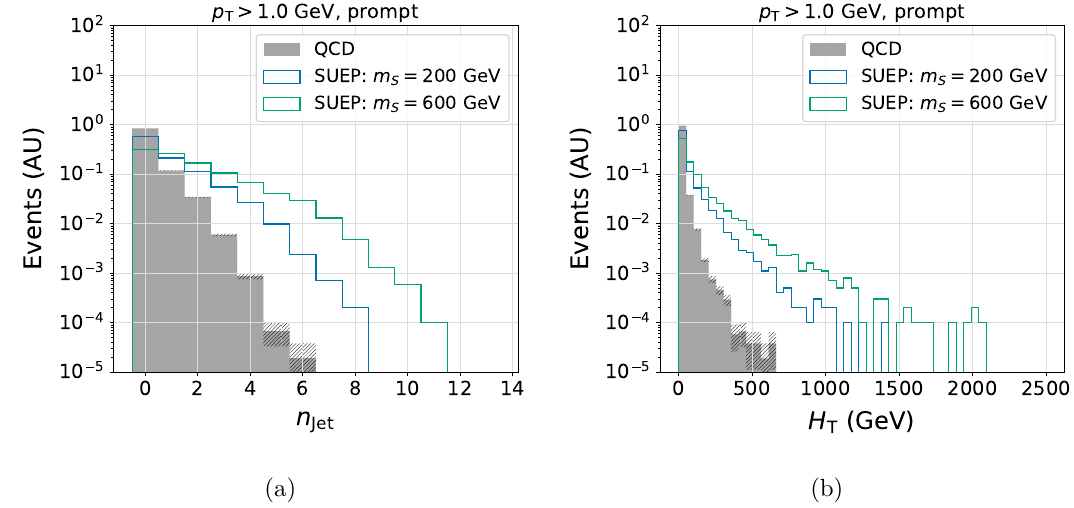
Figure 23. The number of prompt jets (a) and H T (b) for minimum bias QCD and representative SUEP signal samples at 200 pile-up. Jets are reconstructed from prompt tracks with p and jets are required to have p 25 GeV. Slashed bands on the QCD distribution represent the T > statistical